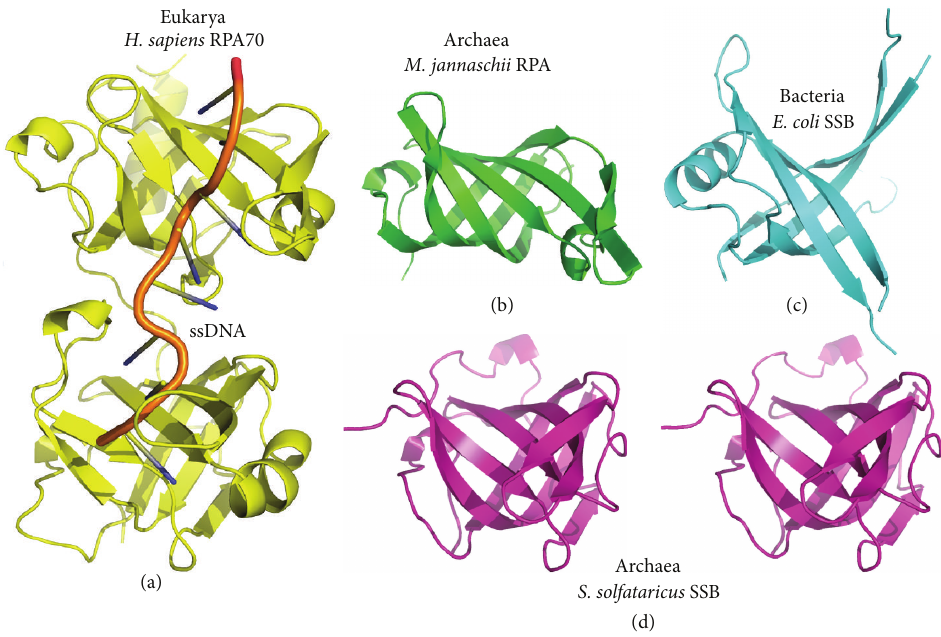
Figure 6: Single-stranded DNA binding proteins. Bacterial members of this class of protein are generally termed SSBs, which stands for single-stranded DNA binding proteins, whereas, originally, eukaryotic versions were called replication protein A (RPA). Archaeal single- stranded DNA binding proteins are generally split between the euryarchaeal RPA proteins and the crenarchaeal SSB proteins. The DNA binding elements of these single-stranded DNA binding proteins are oligosaccharide/oligonucleotide binding (OB) folds. (a) Two tandem OB folds representing residues 181–422 from the largest subunit of human replication protein A, RPA70 (PDB code 1JMC), reveal the binding mode to ssDNA. (b) Example of the OB fold from the euryarchaeal M. jannaschii RPA structure (PDB code 3DM3 chain A). The structure is in the same orientation as the top domain in (a). (c) An example of a bacterial SSB domain from E. coli . (PDB code 1SRU chain A). (d) The characterization of a crenarchaeal SSB protein from S. solfataricus , whose OB fold (stereoview shown in same orientation as the bottom domain in (a), PDB code 1O7I chain A) resembles that of eukaryal RPA. Interestingly, its overall domain organization is more similar to bacterial SSBs, and this led to the discovery of additional single-stranded DNA binding proteins in